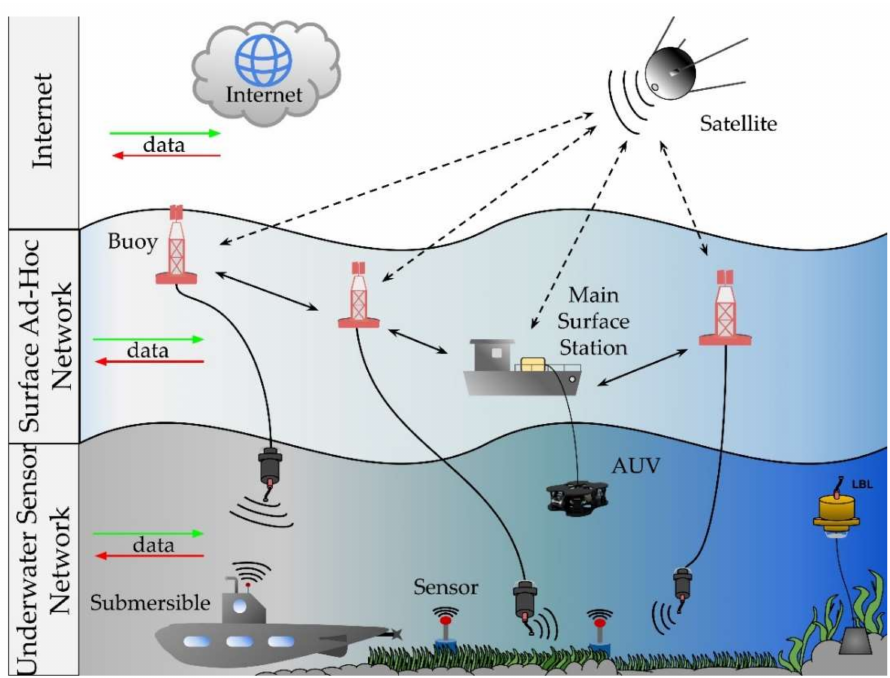
Figure 8. MIoT architecture based on the environment of finding different devices and interaction